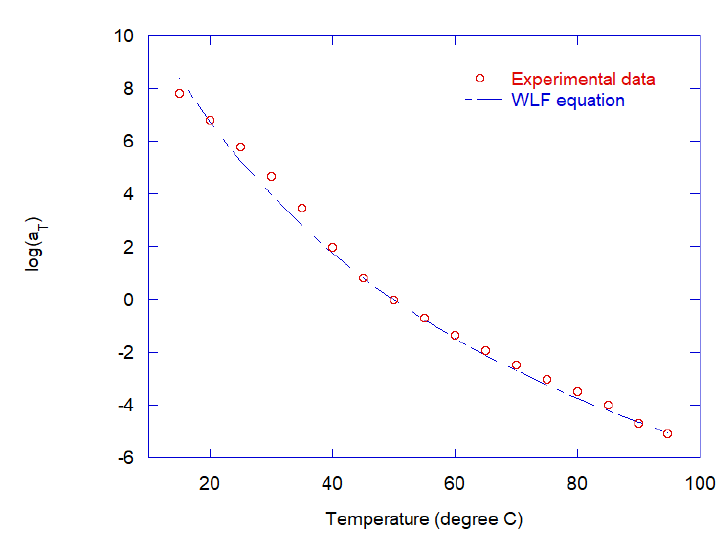
Figure 10. Shift factors of Polymer A.